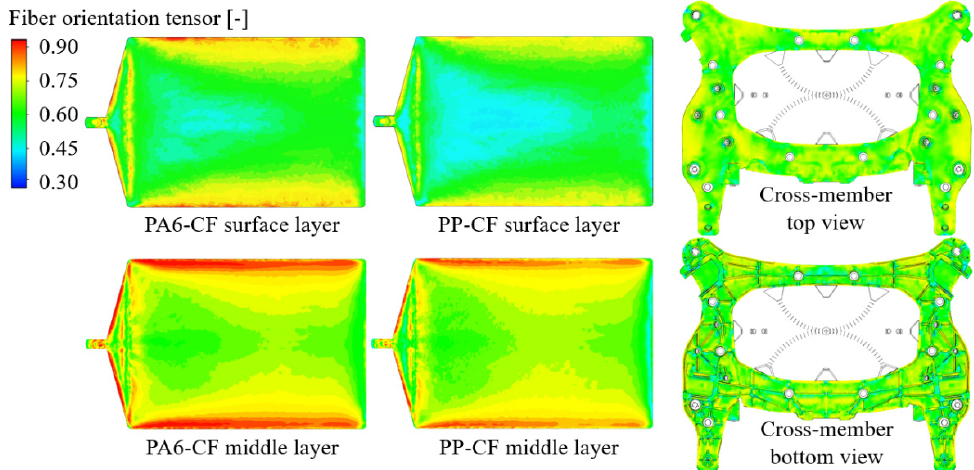
Figure 12. Fiber orientation distribution of surface and middle layer of injection molded plate, and